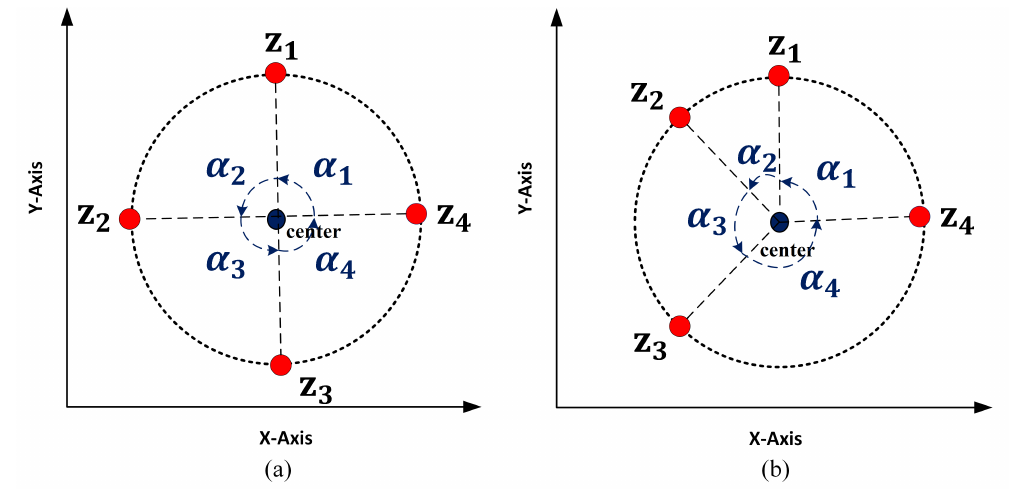
Figure 1. Circular formation of four agents in a plane: ( a ) evenly spaced circular formation with equal angular separation α i = 2 π ; ( b ) arbitrary spaced circular formation with unequal angular n separation α i (cid:54) = 2 π n